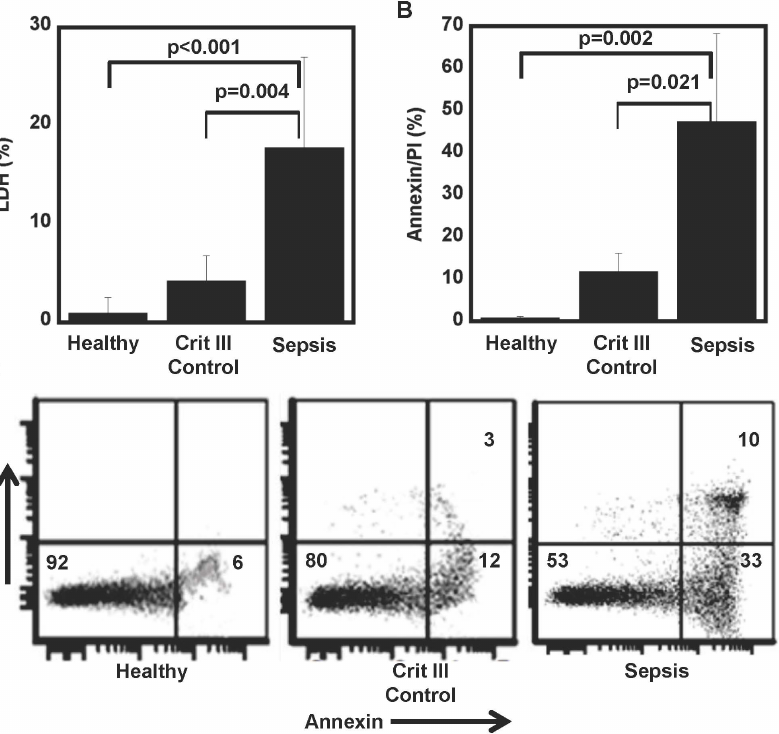
Figure 2. Septic patient microvesicles induce lymphocyte cell death. Plasma was collected from healthy donors (n=10), critically ill non- septic patients (n=6), and septic patients (n=5) and microvesicles were harvested as previously described. Lymphocytes from healthy donors were then incubated overnight with MVs from these respective donors. Cell death was measured by LDH ( A ) and Annexin V/PI assays ( B ). Representative Annexin V/PI assay using flow cytometry exemplified in ( C ). Wilcoxon rank sum test between three groups was significant (p , 0.01) for both LDH and Annexin assays and subsequent between group pair-wise comparison via Wilcoxon test are shown. There was no significant difference in cell death or apoptosis between the healthy controls or critically ill control patients, however septic patients had significantly more cell death and apoptosis compared to both healthy controls and critically ill control patients.